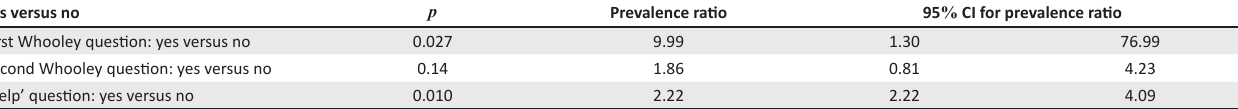
TABLE 2: Impact of the Whooley questions, including the ‘help’ question, on the diagnosis of depression. Yes versus no p Prevalence ratio